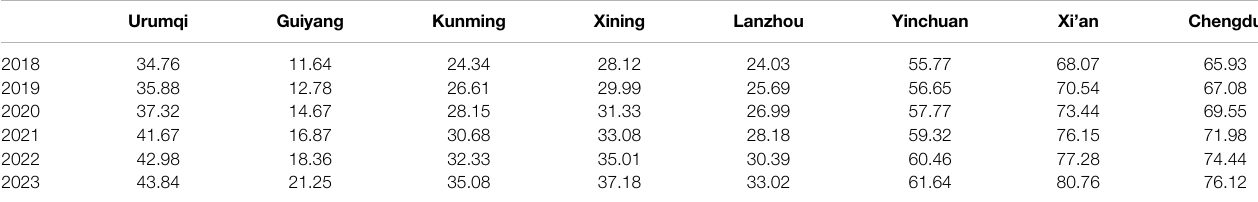
TABLE 5 | Forecast trends in urban household electricity consumption in the Western Region (in billion kWh). Urumqi Guiyang Kunming Xining Lanzhou Yinchuan Xi ’ an